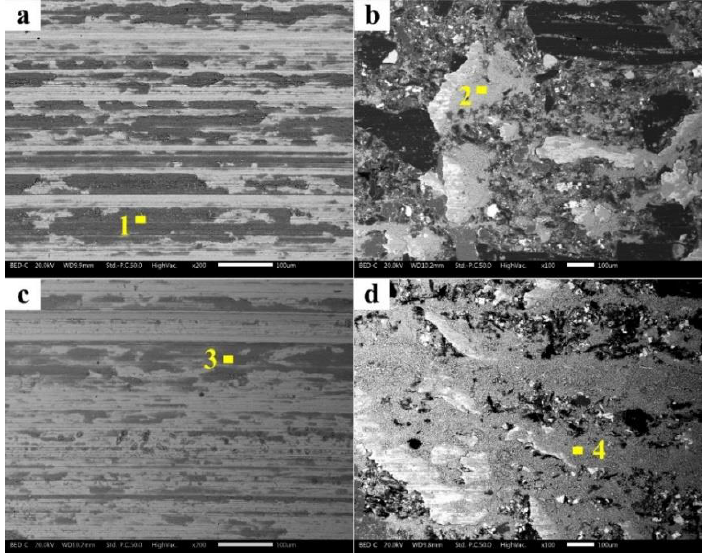
Figure 8. SEM of the pin and counterpart F55 + AISI415-coated disc: ( a ) coating surface and ( b ) pin A; ( c ) coating surface and ( d ) pin B. Numbers 1, 2, 3, 4 placed on secondary plateaus where EDXS analyses were carried out (results in Table 5).